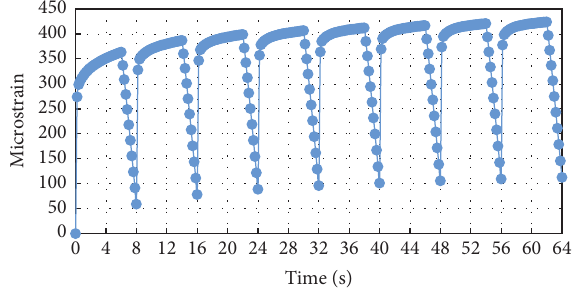
Figure 10: Strain-time